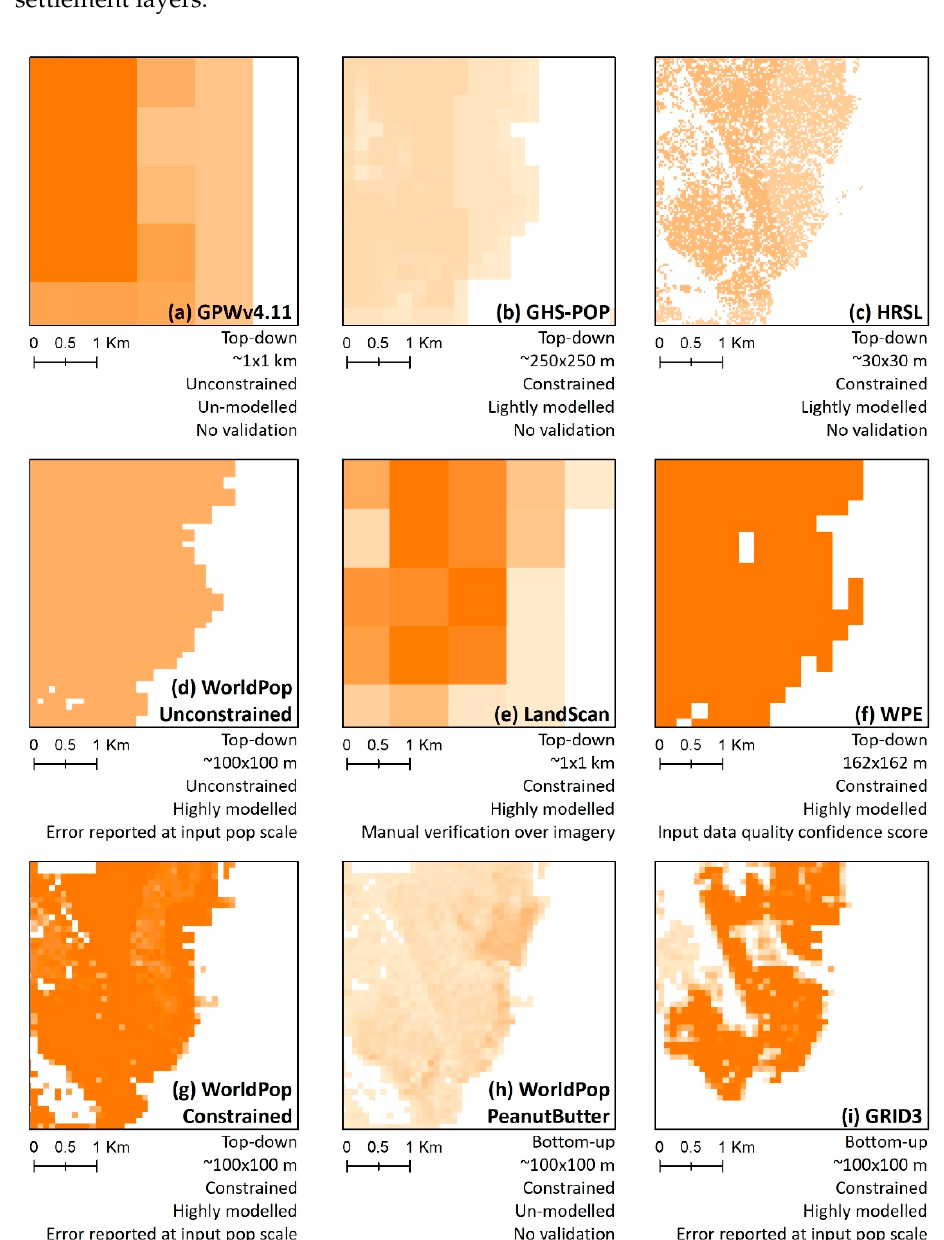
Figure 4. Visual comparison of nine gridded population datasets in their native resolutions for an area along the Lagos Lagoon (Nigeria). Dark orange = higher population density, white = zero population estimate. ( a ) Gridded Population of the World by Columbia University’s Center for International Earth Science Information Network (CIESIN). ( b ) Global Human Settlement Population Layer by the European Commission Joint Research Centre. ( c ) High Resolution Settlement Layer by the Facebook Connectively Lab and CIESIN. ( d ) WorldPop Global Unconstrained by the WorldPop team at University of Southampton. ( e ) LandScan Global by the U.S. Oak Ridge National Labora- tory. ( f ) World Population Estimates by ESRI. ( g ) WorldPop Global Constrained by the WorldPop team at University of Southampton. ( h ) peanutButter algorithm by University of Southampton to estimate population counts from building footprints. ( i ) Geo-Referenced Infrastructure and Demo- graphic Data for Development estimates by WorldPop, CIESIN, Flowminder Foundation, and UN Population Fund with funding from the Bill & Melinda Gates Foundation and UK Department for International Development.